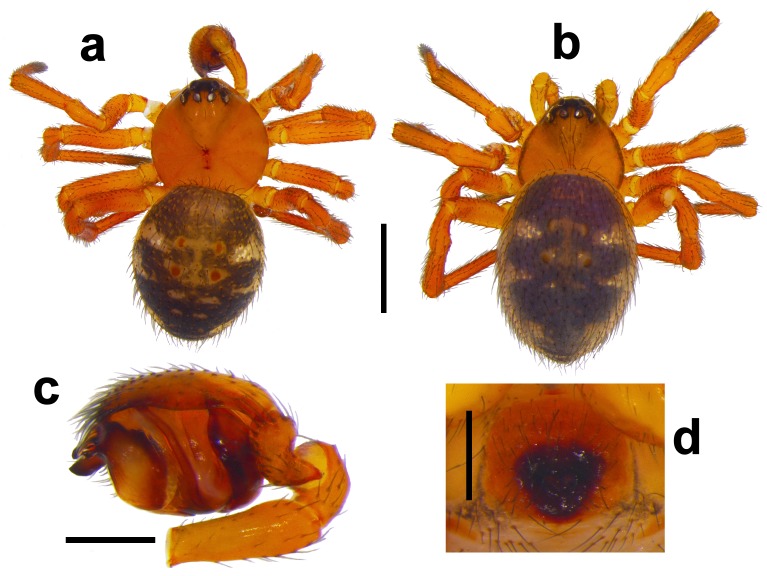
Euryopis
flavomaculata (C. L. Koch, 1836). a: male, dorsal habitus, scale = 1 mm; b: female, dorsal habitus, scale = 1 mm; c: left male palp, retrolateral, scale = 0.3 mm; d: female epigynum, ventral, scale = 0.3 mm.